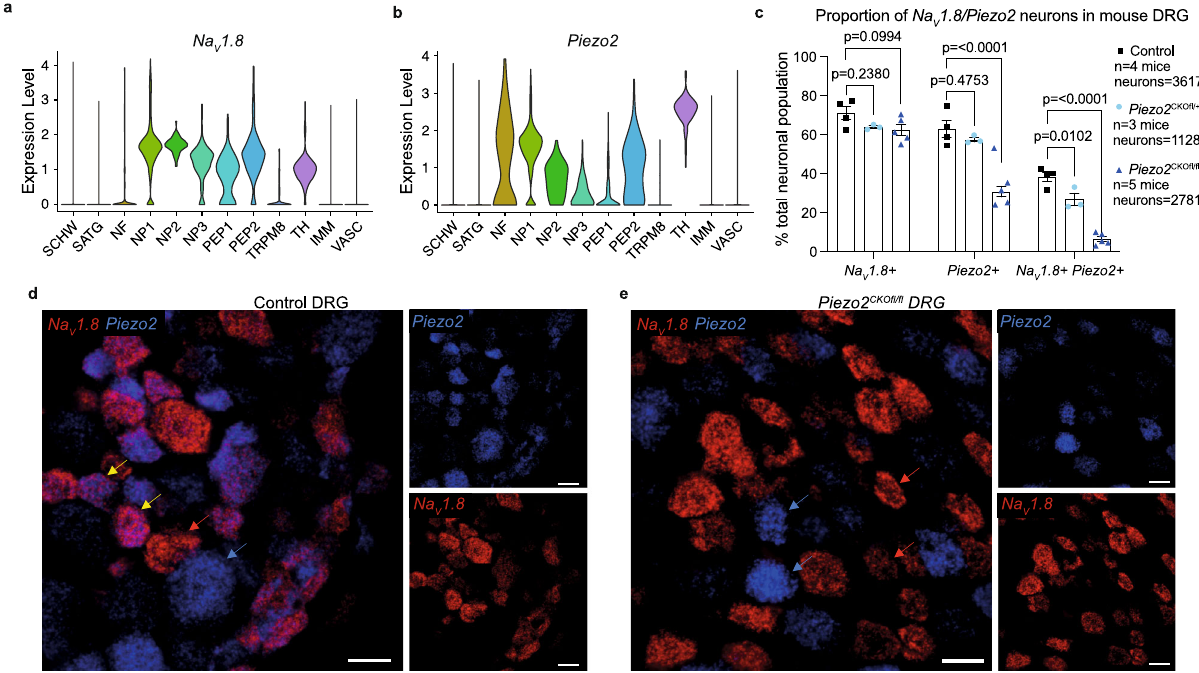
Fig.1|Piezo2isdepletedfromnociceptorsusingthemarkerNa V 1.8.a , b ScRNA- seq of naive L3-L5 dorsal root ganglion (DRG) cells demonstrates that Piezo2 is expressed by a subset of nociceptors ( Na V 1.8 +neurons) in addition to large dia- meter neurons (NF; Na V 1.8 − neurons); SCHW Schwann cells, SATGsatellite glia,NF neuro fi lament, NP non-peptidergic nociceptors, PEP peptidergic nociceptors, TRPM8 transient receptor potential melastatin 8, TH tyrosine hydroxylase con- taining, IMM immune cells, VASC vascular cells. c – e Piezo2 was deleted in noci- ceptorsbyusingthemarker Na V 1.8 .RNAscopewasused toquantifythe numberof